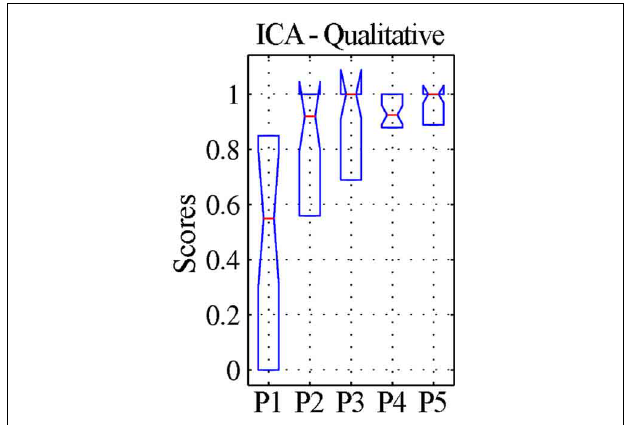
FIGURE 2 | Qualitative evaluation of the detectability of the whole default-mode network (DMN) extracted by ICA for patients. The values represent visual assessment scores for activity across the four main nodes (PCC, precuneus; LP R , right lateral parietal cortex; LP L , left lateral parietal cortex; MPFC, medial prefrontal cortex), averaged between the two raters and normalized within each patient, so that the maximum score of 1 corresponds to the best qualitative appearance of the DMN observed for each case (see text). The box-plots represent the median and inter-quartile ranges of the visual assessment scores. As preprocessing steps were added to the pipeline (P1–P5), the dispersion diminished and the median approached unity, confirming that the DMN was best identifiable after preprocessing using procedure